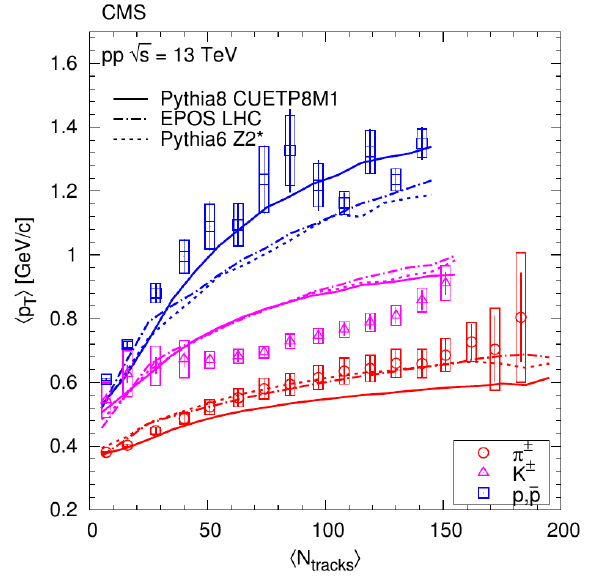
Figure 12. Measurement of the average p T of identified particles versus the average number of charged tracks N tracks in proton- proton collisions at 13TeV, see Ref.